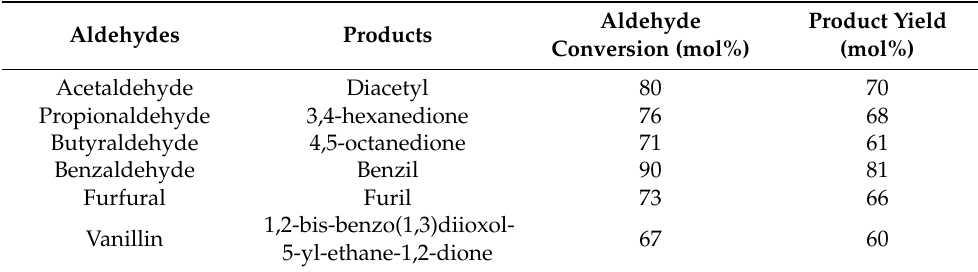
Table 3. Pinacol-type oxidative coupling reactions of the different aldehydes promoted by the